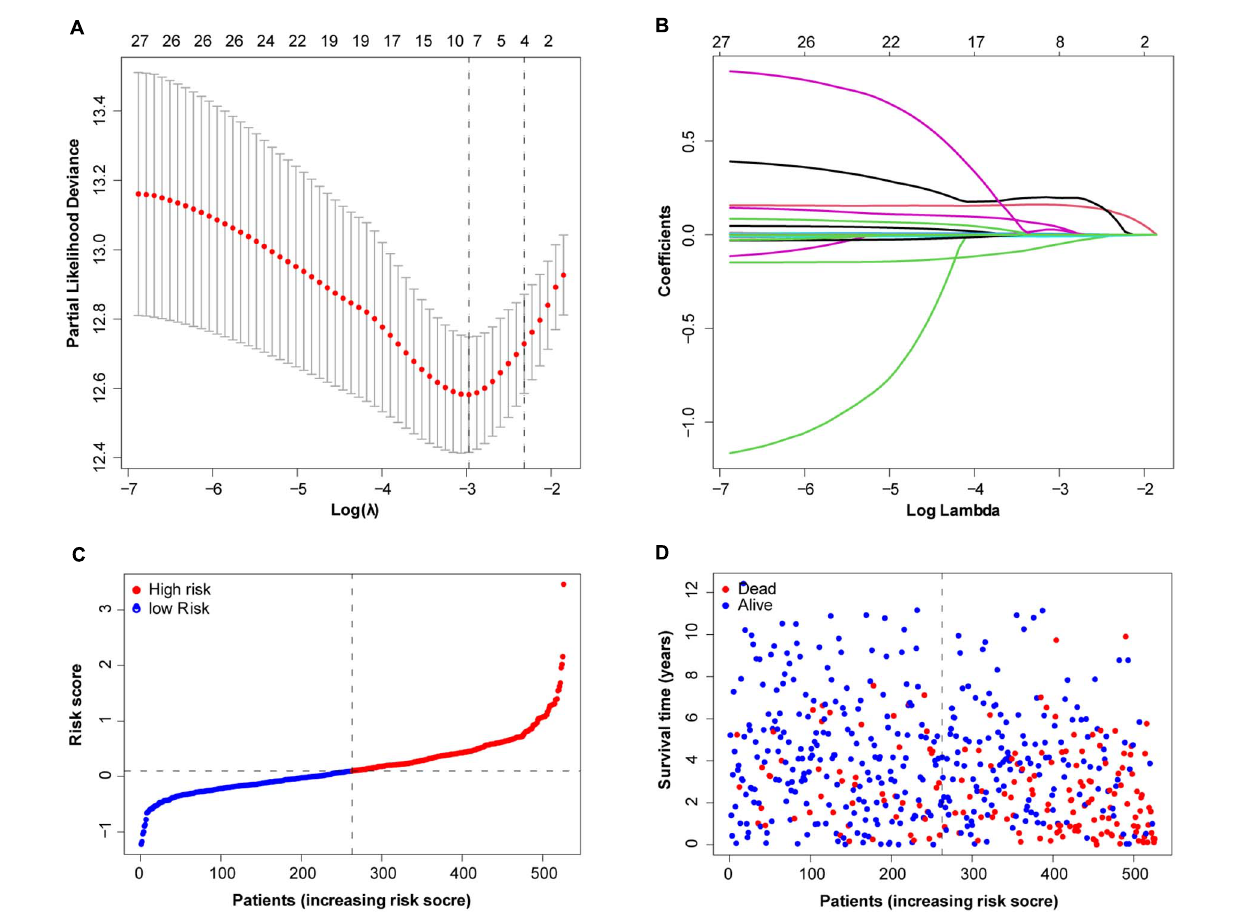
FIGURE 2 | Determination of ferroptosis-related genes (FRGs) as an independent prognostic factor. (A) Partial likelihood deviance was plotted against log (lambda). Vertical dotted lines indicate the lambda value with minimum error. The largest lambda value is where the deviation is within one standard error (SE) of the minimum. (B) Least absolute shrinkage and selection operator (LASSO) coefficient profiles of FRGs and selected seven FRGs. (C) Risk score curve of ferroptosis signature. (D) Patient survival status and time distributed by FRG-based risk